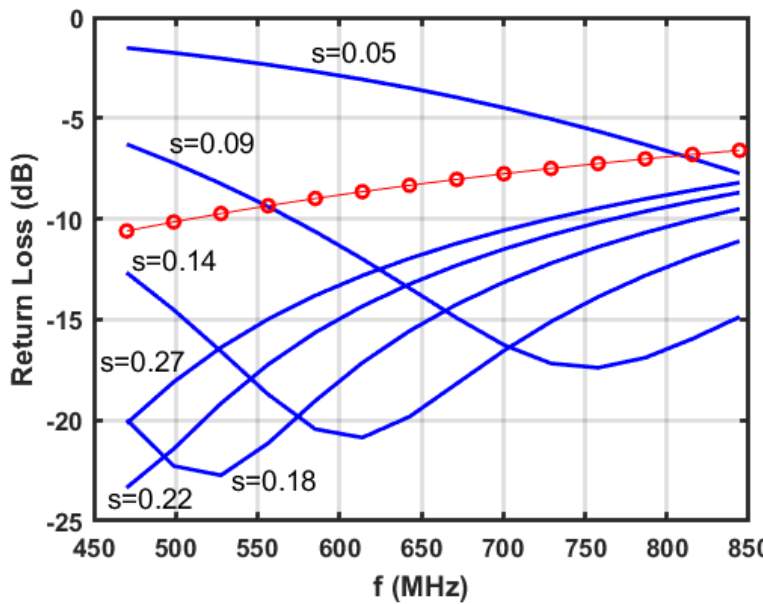
Figure 7. Return losses [470 MHz, 806 MHz]) in radome having wire = 0.8 mmØ, and thickness = 16 mm: (-o-)without helical wire. (---) with helical, wire spacing between turns s = 0.05, 0.9, 0.14, 0.18, 0.22, 0.27 m.